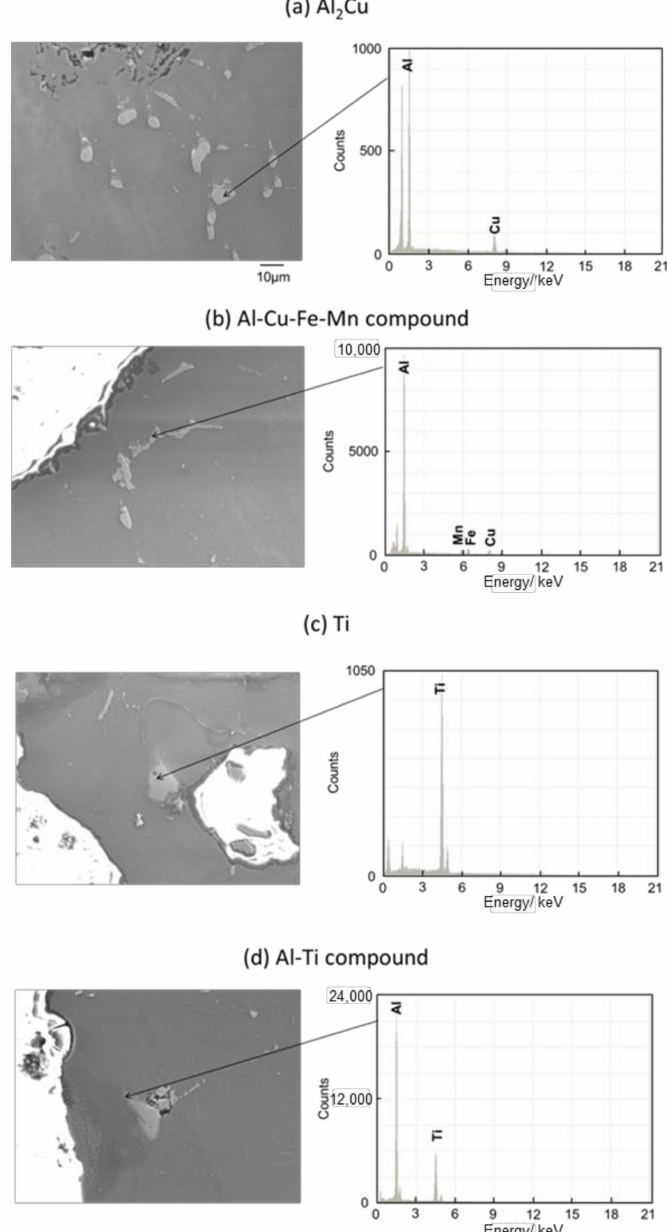
Figure 11. Scanning electron microscope (SEM) images of intermetallic compounds and energy dispersive X-ray spectroscopy (EDS) analysis in the cell wall of